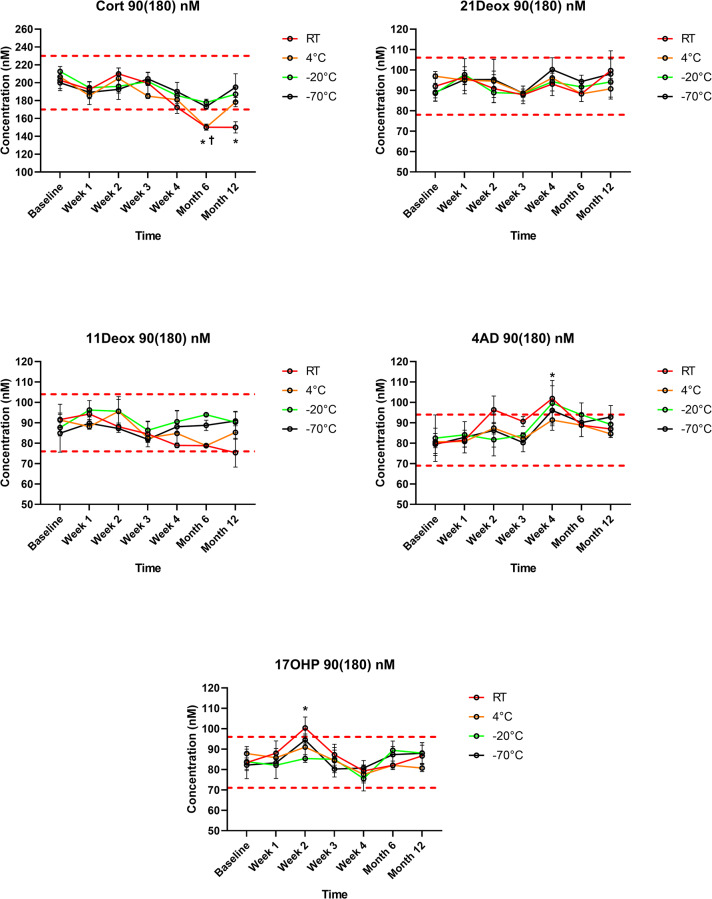
Steroid concentrations in the 90(180) nM test samples during storage within 1 year at different temperatures (n = 3 for each data point).Values are given means±SD. Cort: cortisol; 21Deox: 21-deoxycortisol; 11Deox: 11-deoxycortisol; 4AD: 4-androstenedione; 17OHP: 17-hydroxyprogesterone; RT: room temperature. Dashed red lines indicate upper and lower cutoffs of the predetermined ranges (±15% vs Week 0), within which analytes were considered stable. * p<0.01 vs the baseline at room temperature; † p<0.01 vs the baseline at 4 °C. Error bars for SD values smaller than the respective symbol size are not visible.